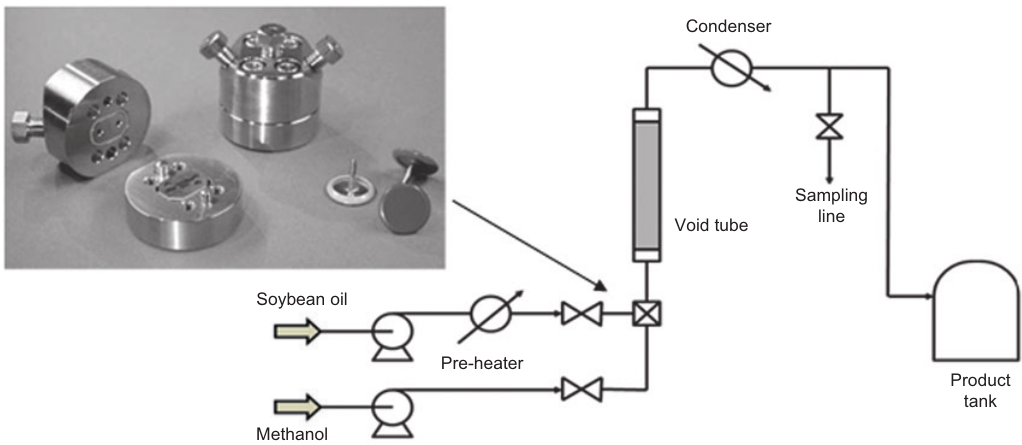
Figure 1 Slit Interdigital Micro Mixer Version 2 (SIMM-V2) produced by IMM (Institut fur Mikrotechnik Mainz GmbH). With the permis- sion from IMM [15] .